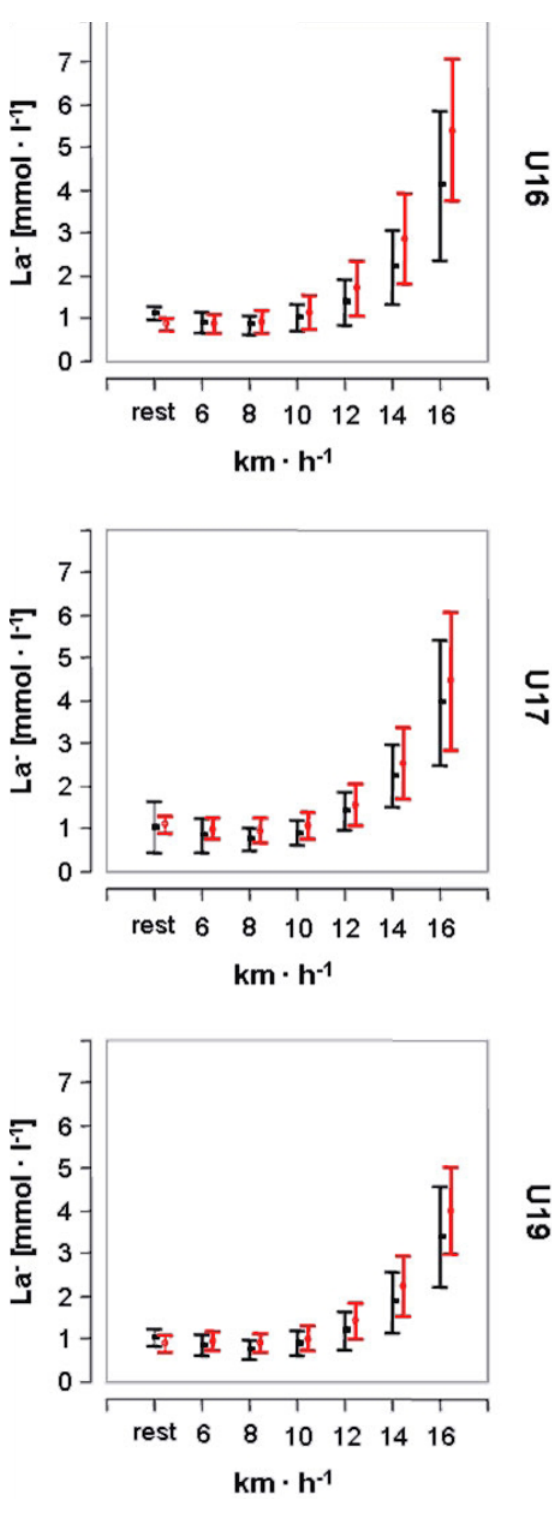
Figure 3. Lactate levels at fixed running velocities for the three groups U16, U17 und U19 before ( ■ ) and after ( ● ) a 5 weeks preseason trainig phase (means and SD).